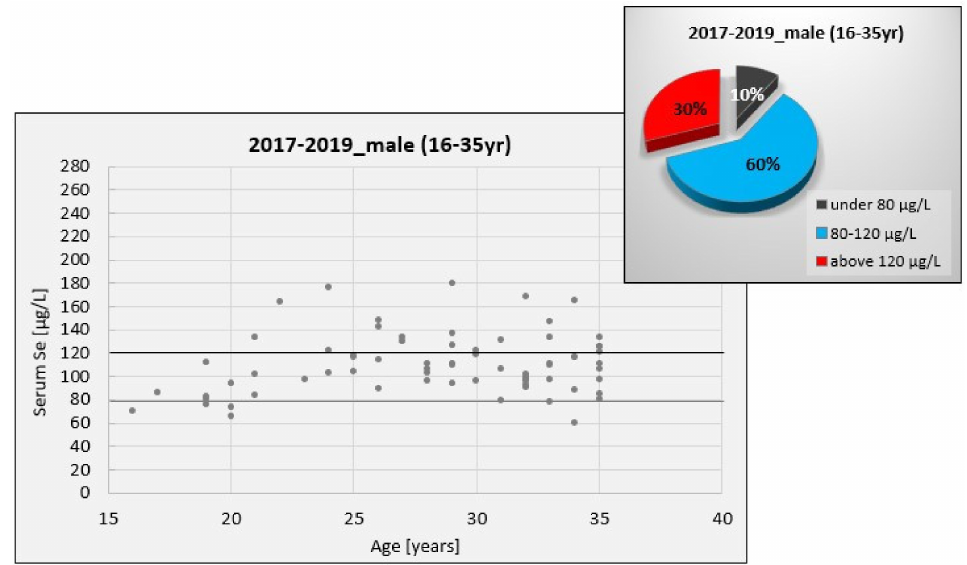
Figure 7. Distribution of SeS values in the young male population compared to the reference range of 80–120 µ